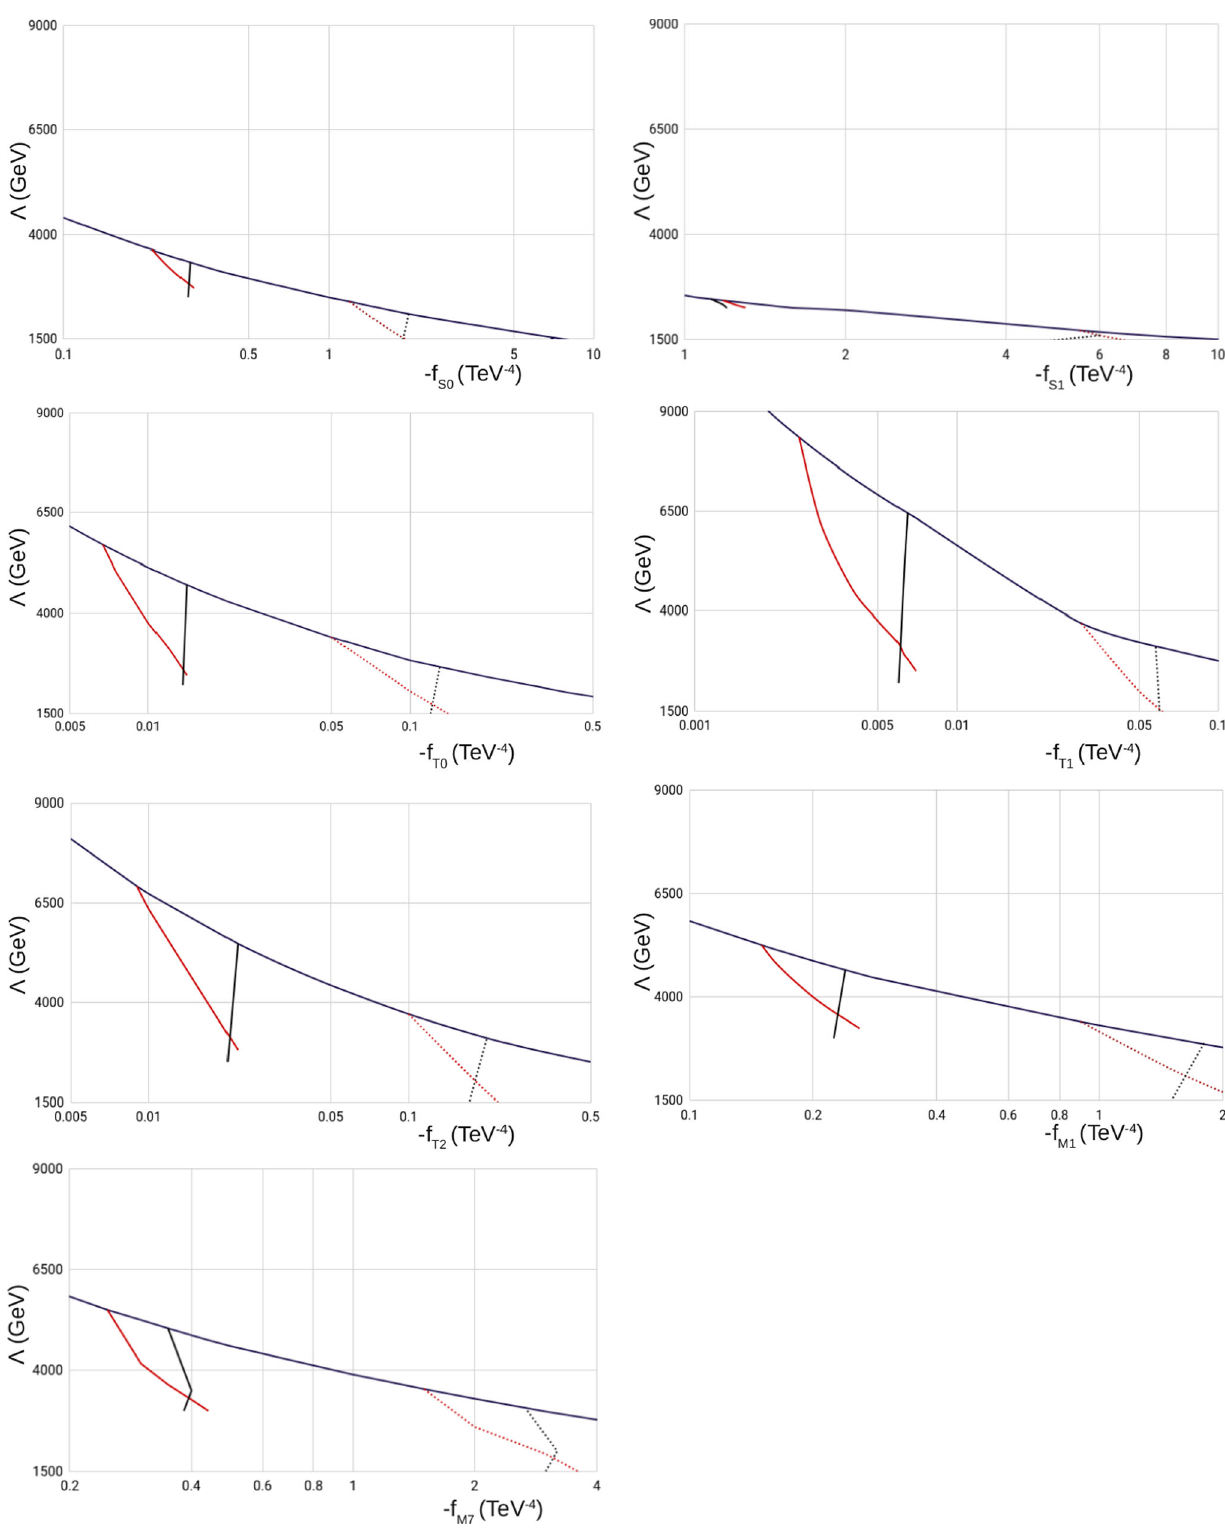
Fig. 3 Regions in the (cid:2) vs f (negative f values) space for dimension- 8 operators in which a 5 σ BSM signal can be observed and the EFT is applicable. The unitarity limit is shown in blue; the lower limits